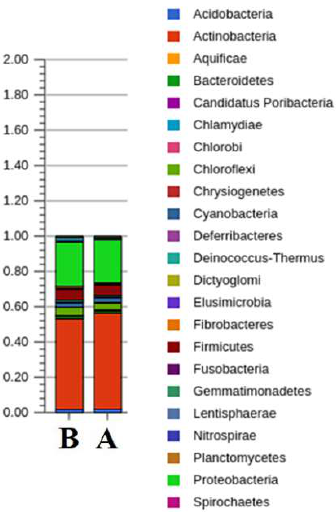
Figure 6. Stacked bar charts representing relative phylum-level abundances for the most abundant